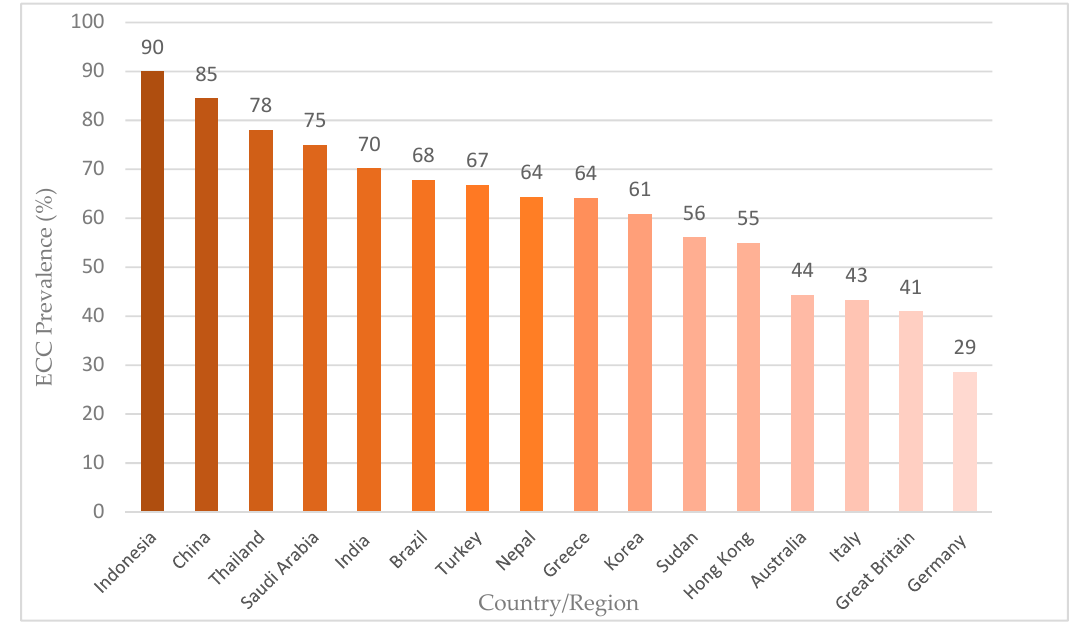
Figure 2. Prevalence of ECC in 5-year-old children (adapted from Chen et al., 2019 [8]).